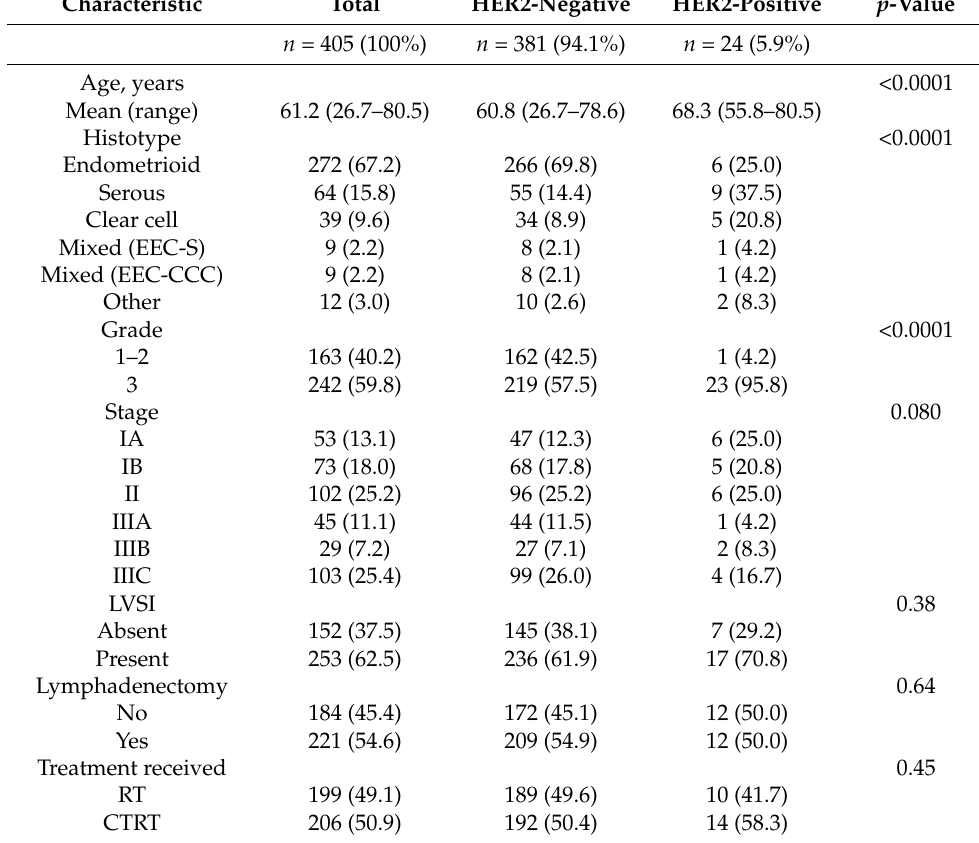
Table 1. Patient, tumor, and treatment characteristics by HER2